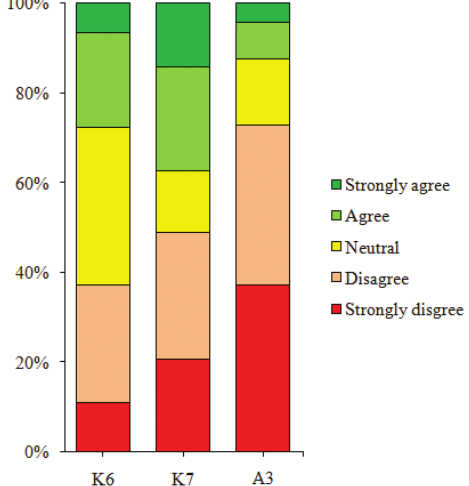
Figure A5. Cumulative responses to K6: “The role of the nucle -